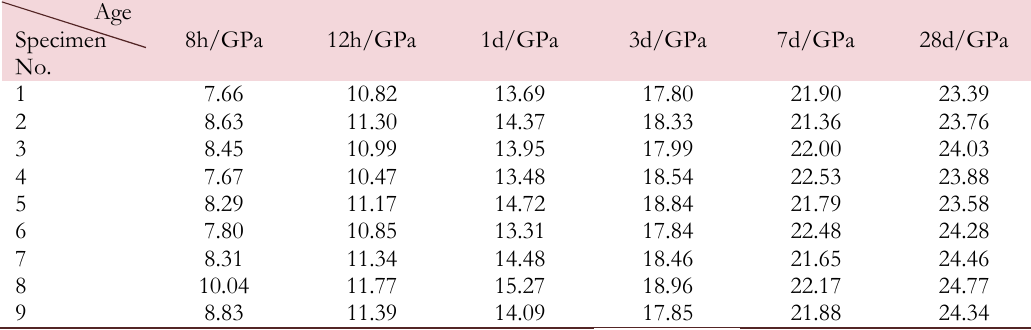
Table 6: Elasticity modulus of shotcrete added with the traditional accelerator